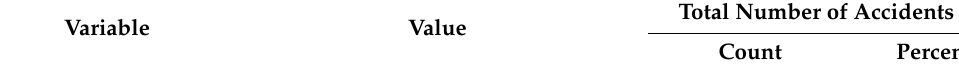
Table 2. Descriptive statistics of accident